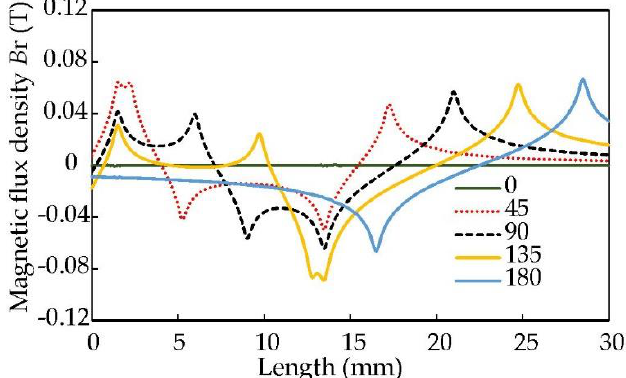
Figure 15. Magnetic flux density radial component.